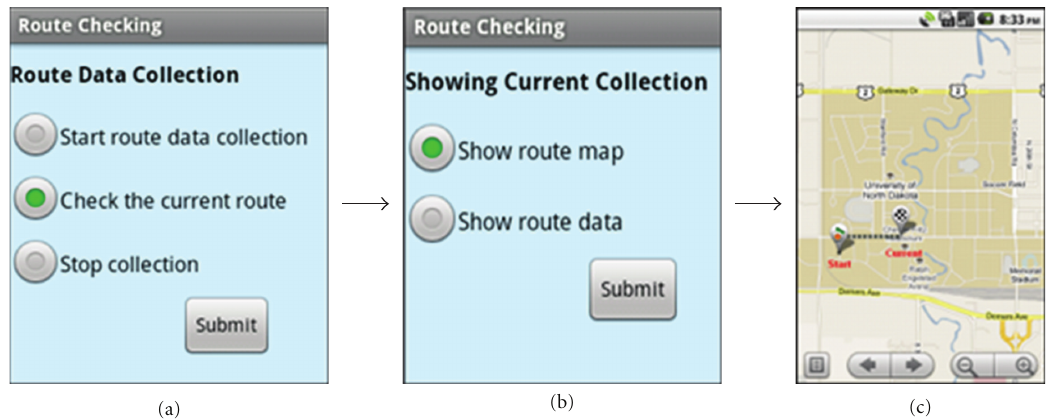
Figure 7: (a) The page of route data collection, (b) the page of checking the current route, and (c) the current route